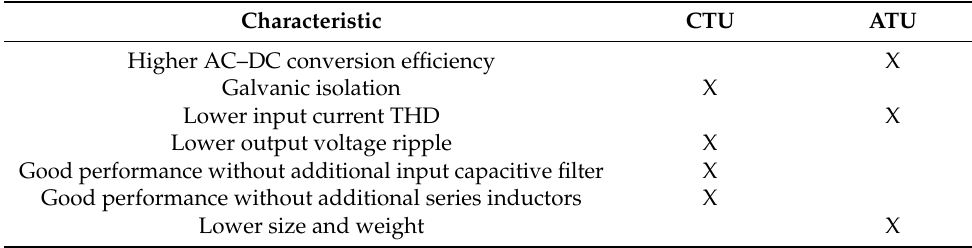
Table 19. Summary of CTU and ATU